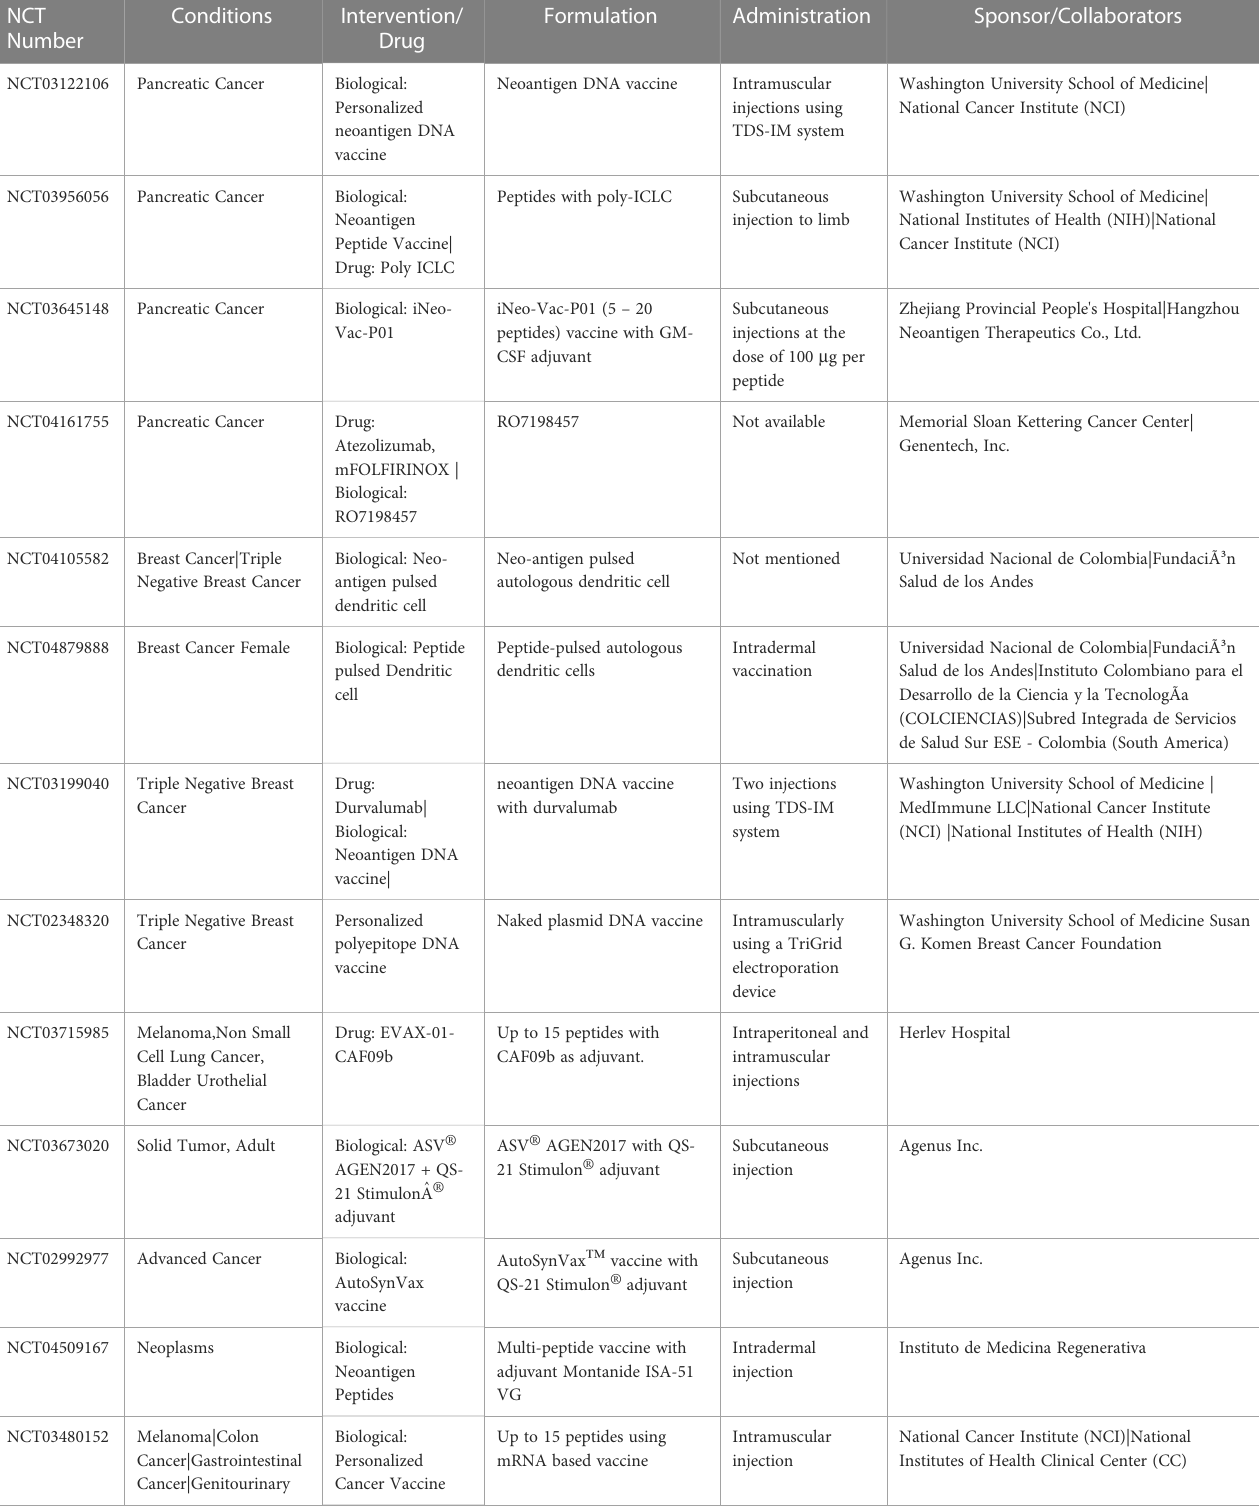
TABLE 1 List of clinical trials using neoantigen vaccine therapy. Data accessed on December 20,